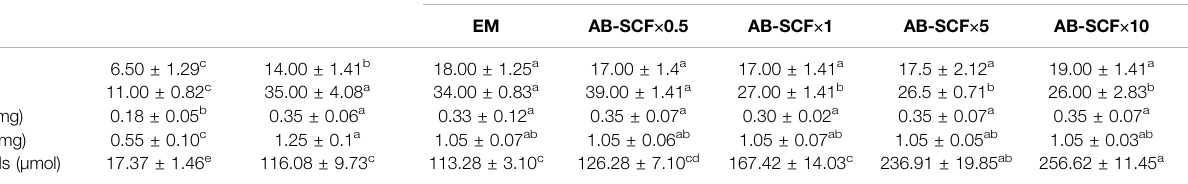
TG,triglyceride;TC,totalcholesterol;LDL-C,low-densitylipoproteincholesterol;HDL-C,high-densitylipoproteincholesterol;HFD,high-fatdiet;EM,Tween80/Span80 (cid:2) 5:1v/v,diluted waterto 5%;AB-SCF,supercritical fl uidextractedaldlaybran.C,ablankcontrolgroupfedwith standardchowdietandwater;HFD,ahighfatdietinducedhyperlipidemicgroupfedwith water; EM, a high fat diet induced fed with the emulsi fi er of AB-SCF; Experimental groups were induced with HFD and administrated AB-SCF/emulsi fi er with a dose-ascending manner, i.e., AB-SCF × 0.5, 30.84 mg/kg/BW; AB-SCF × 1, 61.67 mg/kg/BW; AB-SCF × 5, 308.35 mg/kg/BW; AB-SCF × 10, 616.70 mg/kg/BW. Data are mean ± SD, n (cid:2) 10 hamsters in each group. Means with different letters in the same column were signi fi cantly different at p < 0.05 as statistically analyzed by Duncan ’ s multiple range tests.